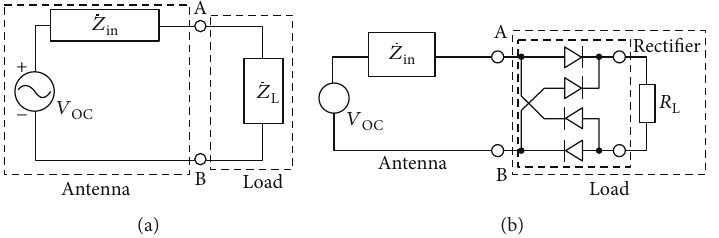
Figure 9: (a) General equivalent circuit of an antenna and a load connected at its input. (b) The equivalent circuit of each dipole, with or without DNG, connected to a full wave recti fi er with resistive load R